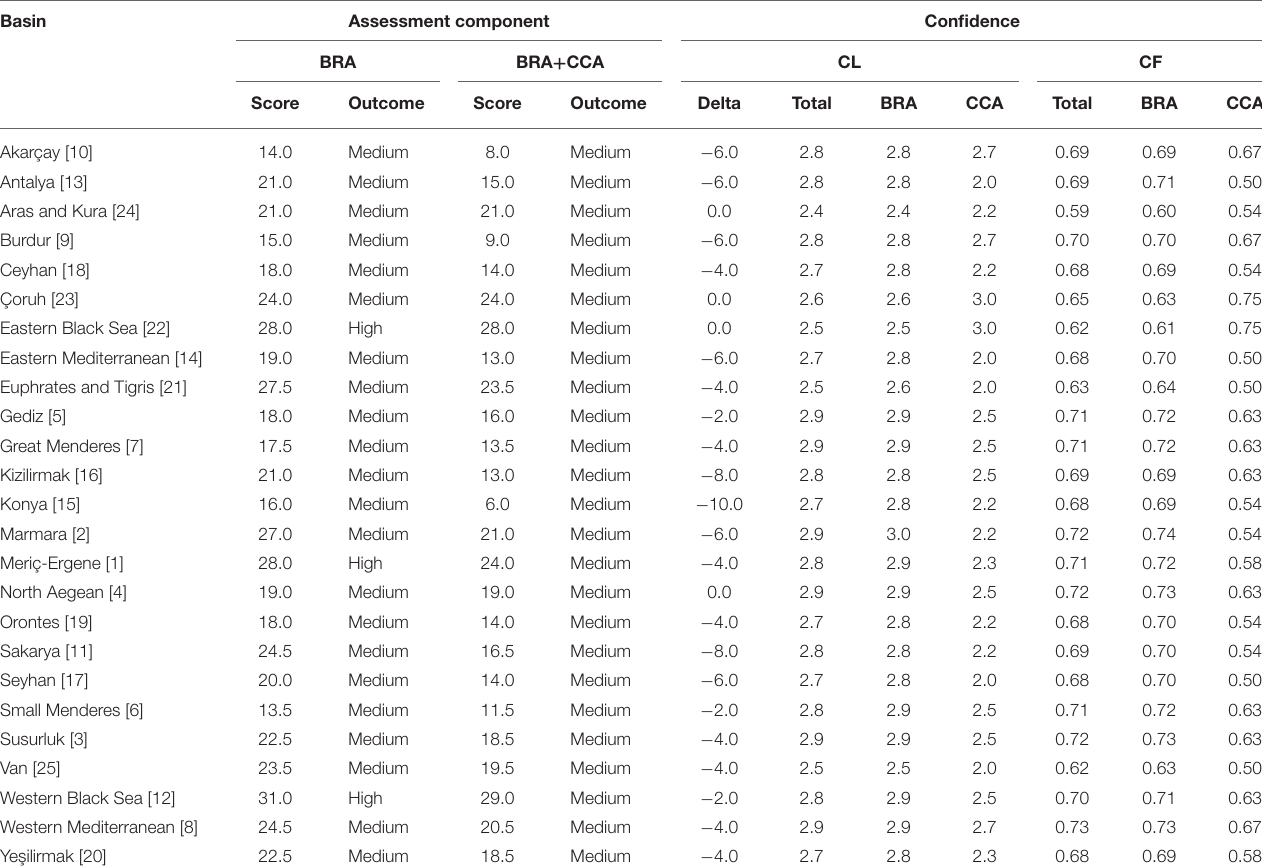
TABLE 1 | Oncorhynchus mykiss screened with Aquatic Species Invasiveness Screening Kit (AS-ISK) for each of the river basins, i.e., risk assessment (RA) areas, that comprise Turkey, numbered (in [ ]) as per Figure 2 .